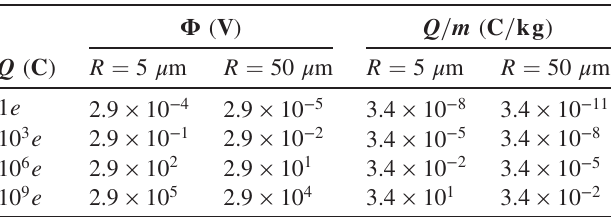
TABLE I. Comparison of the order of magnitude for the charge Q , the surface potential Φ , and the charge-to-mass ratio Q=m of a copper